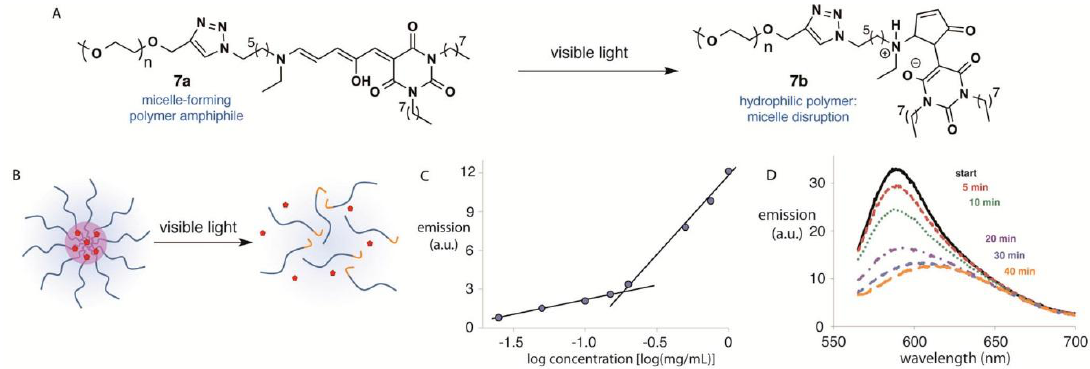
Figure 6. ( A ) Photo-switching of a DASA-functionalized polymeric amphiphile; ( B ) schematic of micelle formation and hydrophobic cargo encapsulation by a photo-responsive amphiphile and micelle disruption and cargo release upon irradiation with visible light; ( C ) fluorescence intensity (emission at 588 nm) vs. log concentration (mg/mL) of the polymeric amphiphile; and ( D ) fluorescence emission spectra of Nile Red in 0.50 mg/mL of the polymeric amphiphile in water at various times of irradiation. Reprinted with permission from Ref. [152]. Copyright 2014 American Chemical Society.